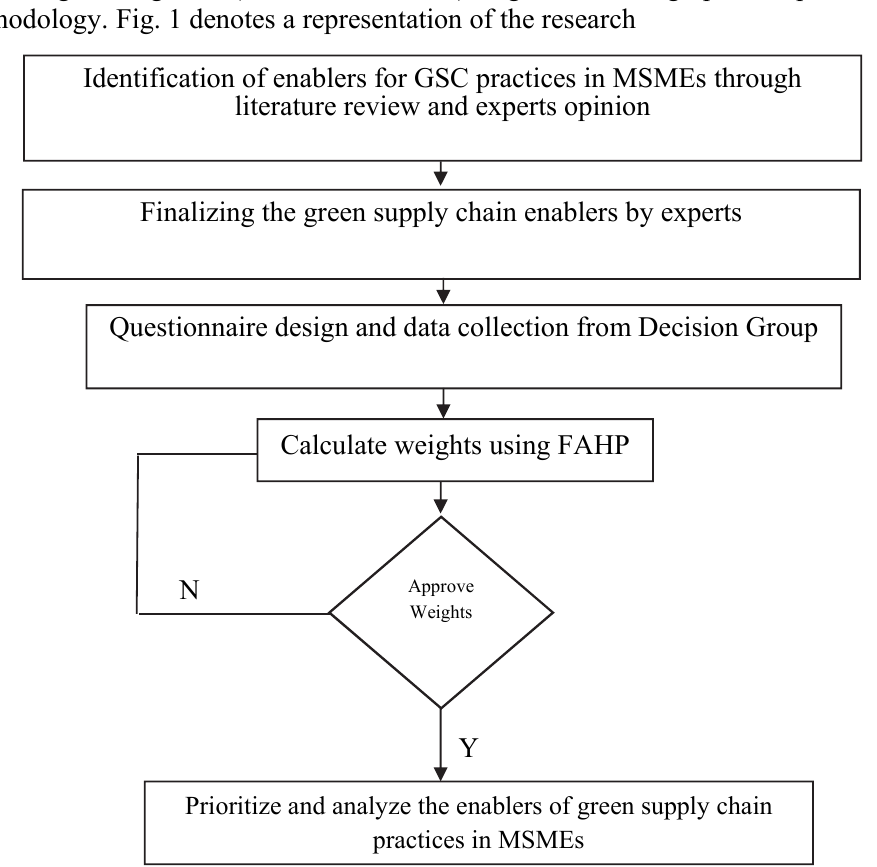
Fig. 1. Proposed FAHP methodology for GSC management enablers in MSMEs